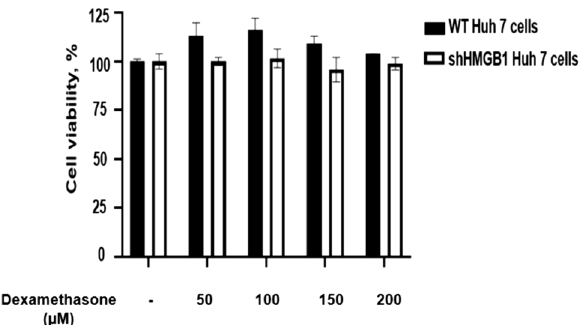
Figure 4. Cytotoxic effects of dexamethasone on wild-type (WT) and HMGB1-knockdown (shHMGB1) Huh7 cells. The cytotoxicity of dexamethasone was determined using the MTS assay. Both cells were treated